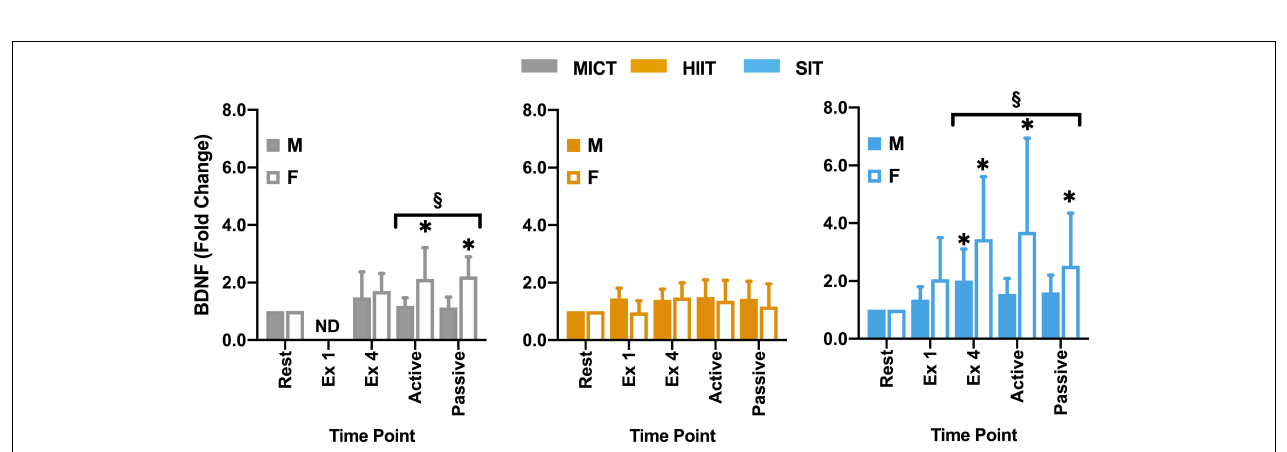
FIGURE 6 | Blood plasma samples were taken were taken during seated rest (Rest); immediately after the first interval exercise bout (Ex 1; HIIT and SIT only); at the end of exercise (Ex 4); end of active recovery (Active)’ and end of passive recovery (Passive). Brain-derived neurotrophic factor (BDNF; n = 21, 7 female) was analyzed by ELISA. Data are presented as mean ± SD . Significance (analyzed by linear mixed model, p < 0.05) between resting values and subsequent time points is denoted by * . Significant differences between sexes at a given time point are denoted by § . M, Male; F, Female; ND, not determined.